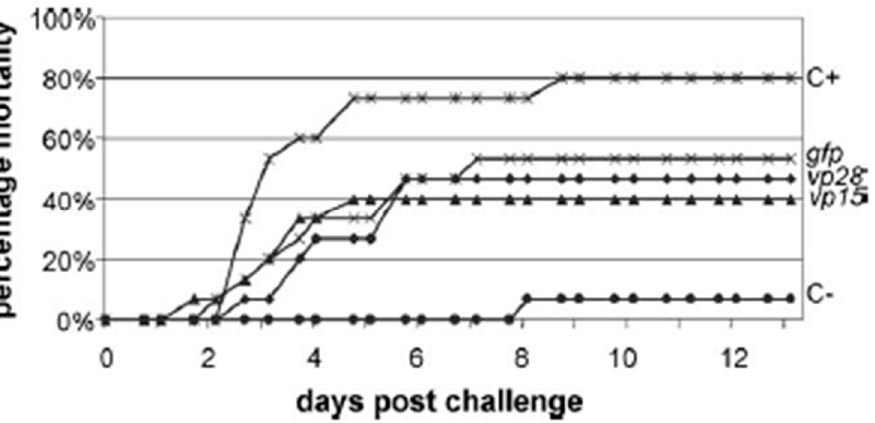
Figure 14. Time–mortality graph of shrimps (Penaeus monodon) injected with siRNAs [141].